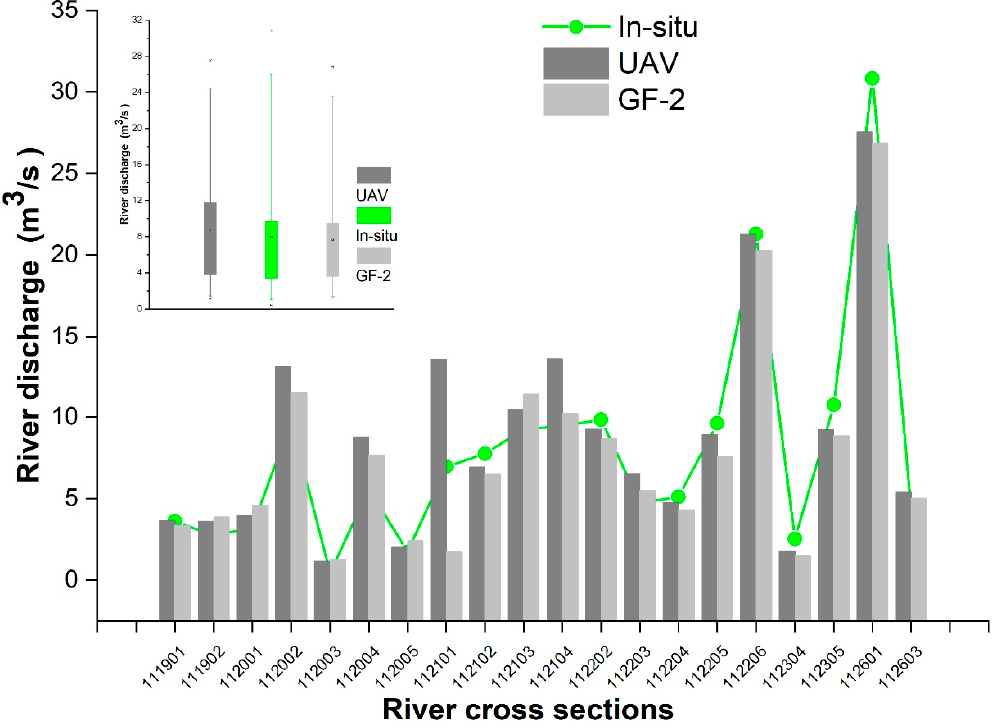
Figure 8. Comparison of the discharge results calculated from the UAV and GF-2 data.